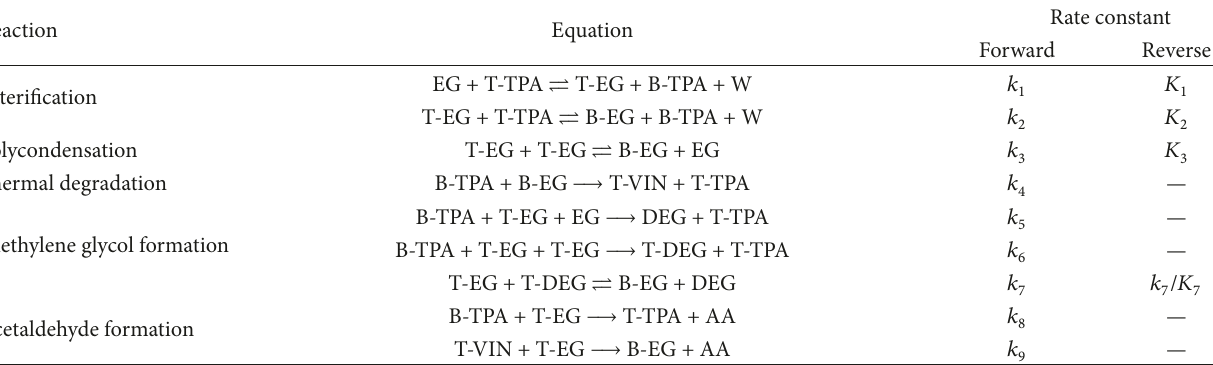
Table 1: Kinetic scheme [27].